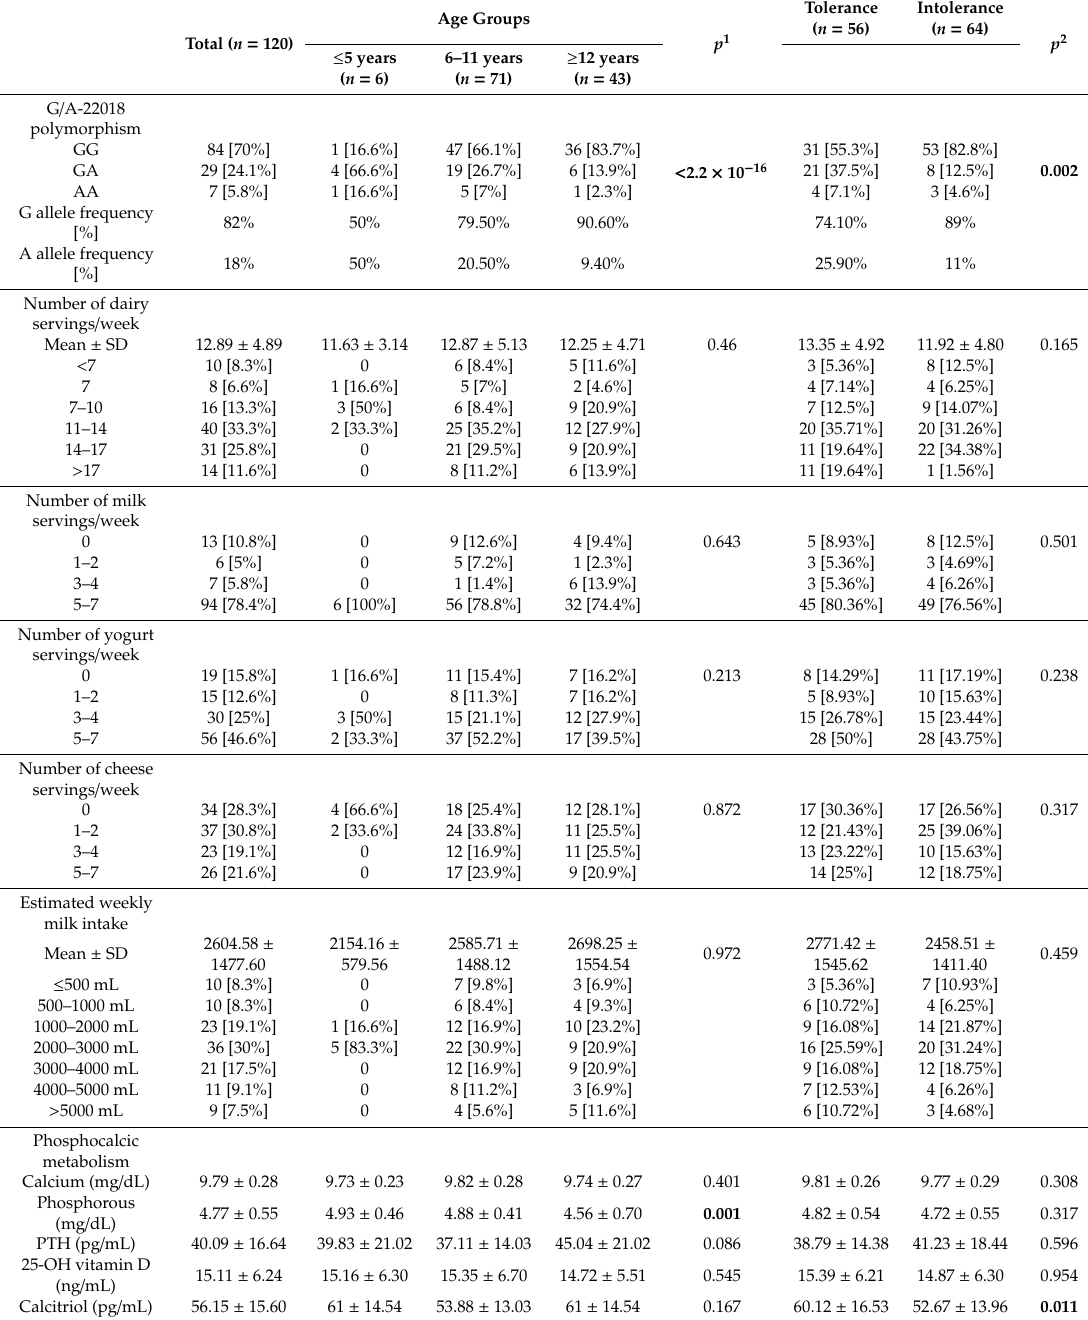
PTH: parathormone. Lactose tolerance is defined as the absence of symptoms during the HBT test and intolerance as the presence of symptoms during it. p 1 , comparison between age groups; p 2 , comparison of lactose tolerant versus lactose intolerant subjects. Percentages are expressed in brackets. Significant values are in